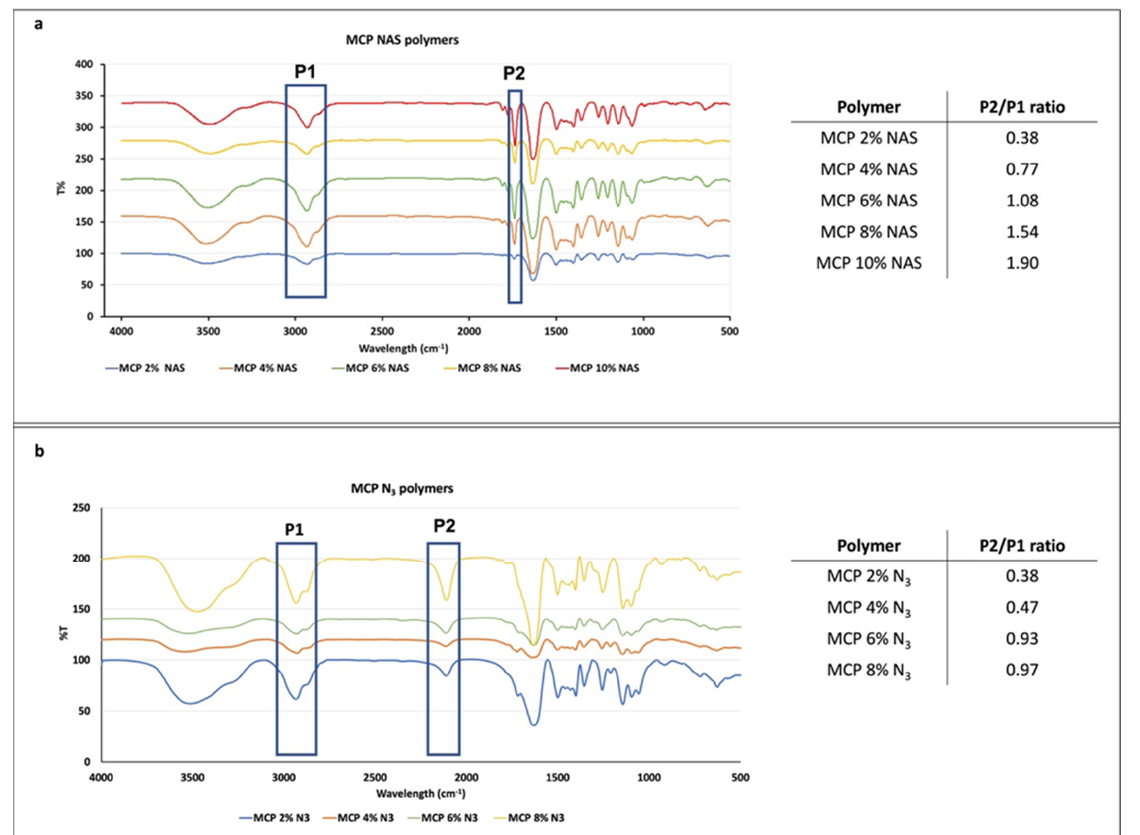
Figure 2. FT-IR spectra of MCP polymers with increasing concentrations of ( a ) NAS or ( b ) azide monomer. The blue rectangles in ( a ) highlight the peak at 3000 cm − 1 and 1740 cm − 1 (corresponding to DMA carbonyl stretching and the NAS ester bond stretching, respectively), while those in ( b ) highlight the 3000 cm − 1 and 2100 cm − 1 peaks (corresponding to DMA carbonyl stretching and N 3 stretching, respectively). The ratio between the height of these two peaks (P2/P1) gives indications regarding the concentration of the functional monomer along the polymer